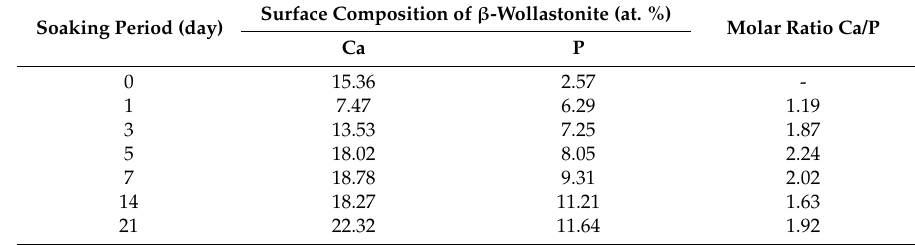
Figure 5. SEM micrographs of β -wollastonite ( a ) control sample and after soaking in the SBF for ( b ) one; ( c ) three; ( d ) five; ( e ) seven; ( f ) 14; and ( g ) 21 days. Table 3. Surface composition of the β -wollastonite samples before and after soaking in SBF solution. Surface Composition of β -Wollastonite (at. %) Soaking Period (day) Molar Ratio Ca/P Ca